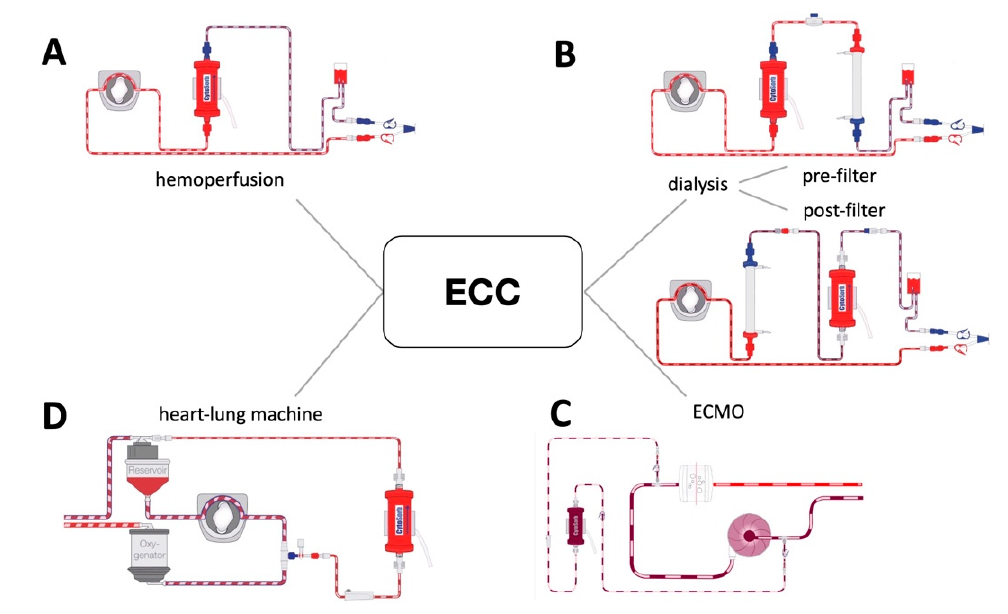
Figure 2. Different possibilities to implement Cytosorb in various extracorporeal circuits. ( A ): integration of CytoSorb into a hemoperfusion circuit; ( B ): integration of CytoSorb in dialysis circuit, pre- or post-filter; ( C ): integration of CytoSorb into heart-lung-machine; ( D ): integration of CytoSorb into an ECMO circuit.